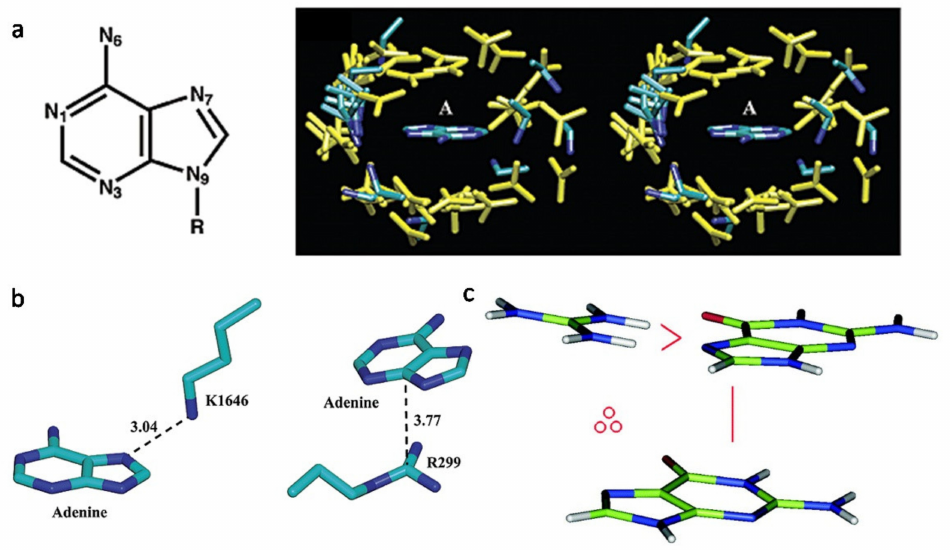
Figure 1. The interaction forces contribute to the aptamer–protein complex formation. ( a ) Pattern of cation– π interactions between charged residues and adenine. ( left ) Molecular structure of adenine. ( right ) A stereo diagram of adenine sur- rounded by positively charged residues in 68 adenine-binding proteins [68]. ( b ) Representative intermolecular interactions between adenine and positively charged residues. ( left ) Lys ··· Adenine pair in the TRP Ca-channel kinase domain (PDB ID: 1IA9); ( right ) Arg ··· Adenine pair in asparagine synthetase (PDB ID: 12AS). The atom − atom distance is indicated by a dashed line and is given in angstroms [68]. ( c ) A color picture to illustrate the H-bond/cation– π stair interaction motif. The depicted stair motif is of type G ∴ Arg ∨ G, where the symbol ∴ means cation– π interaction and ∨ H-bond. Cation– π interactions are defined geometrically by a distance and an angle criterion